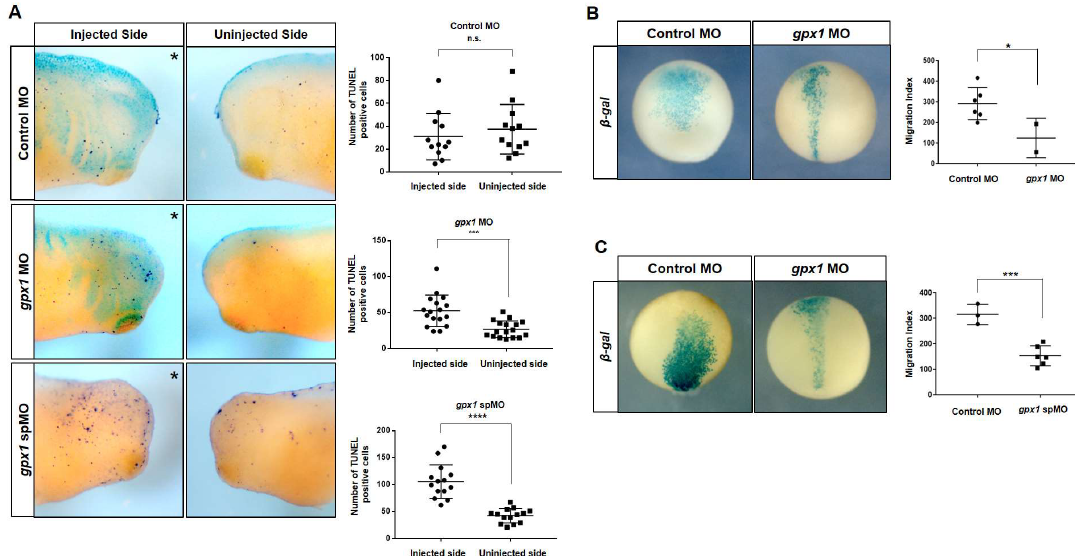
Figure 4. gpx1 depletion activates cell apoptosis and inhibits cell proliferation, as well as affects cell migration during Xenopus embryogenesis. ( A ) The depletion of gpx1 increased TUNEL-positive cells in the eye region of developing gpx1 morphants compared with the control embryos. n.s. > 0.05, *** P ≤ 0.001, **** P ≤ 0.0001. ( B ) gpx1 MO was coinjected with β-galactosidase mRNA into the D.1.2 blastomere of 16-cell stage Xenopus embryos. The staining showed that the cells were concentrated in the midline of the developing gpx1 -depleted embryos compared with the widely distributed cells in the control embryos. The migration index was considerably reduced after gpx1 MO injection. * P ≤ 0.05 ( C ) The injection of gpx1 spMO into the D.1.2. blastomere also resulted in a cell concentration in the midline of developing embryos and decreased the migration index as compared with the control embryos. *** P ≤ 0.001.